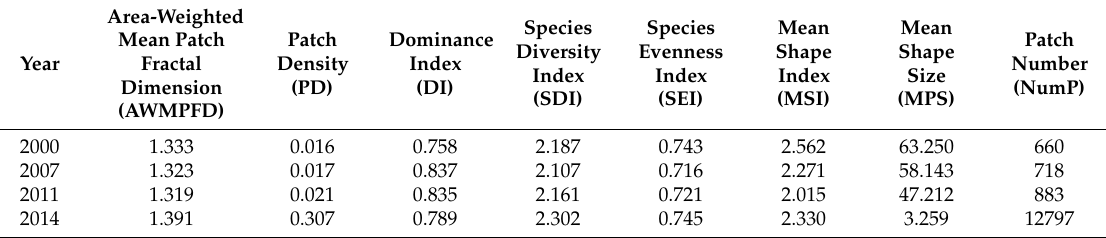
Table 2. The changes in landscape scale and pattern in the